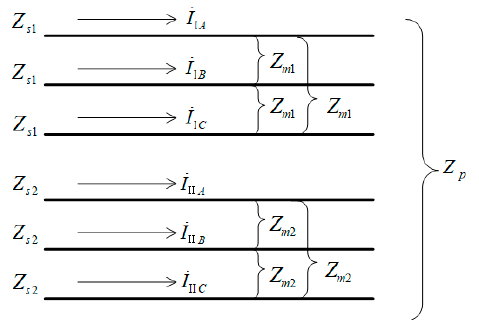
Figure 1. Coupling circuit